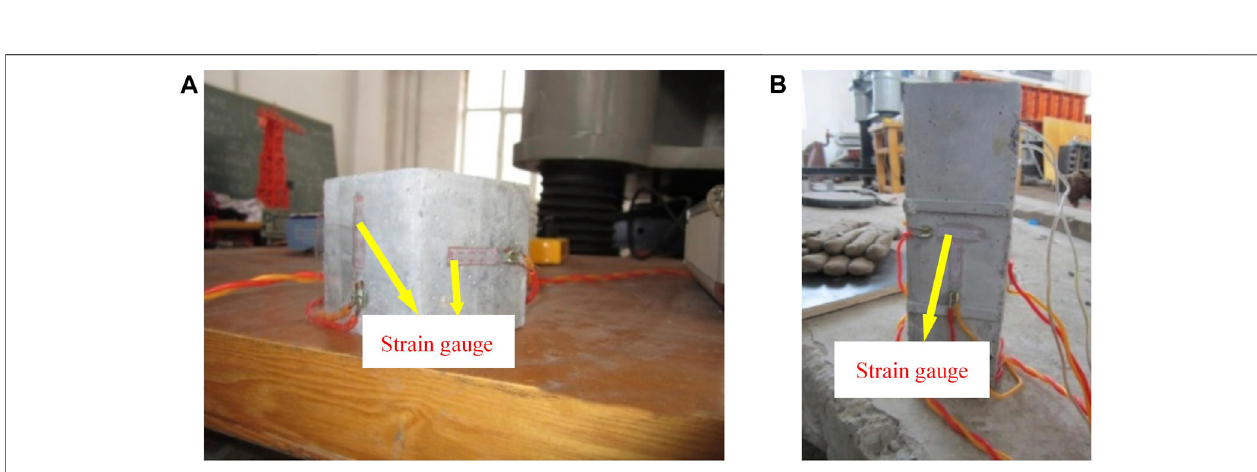
FIGURE 3 | Strain gauge layout of specimens. (A) Strain gauge layout of cube specimen; (B) strain gauge layout of prism specimen.